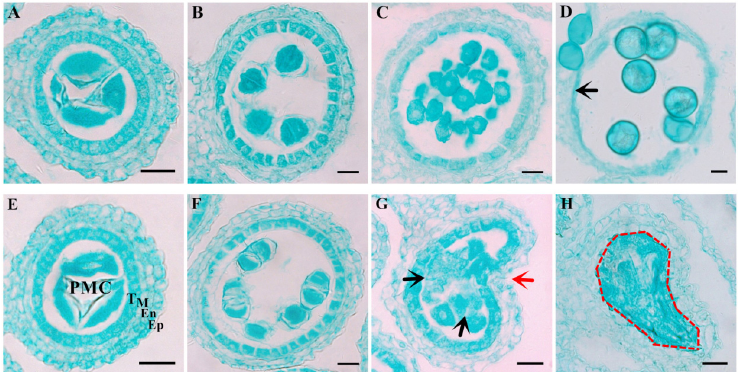
Figure 2. Cytological comparison of anther development in ms305 and fertile sibling at di ff erent stages. ( A – D ) Anther transverse sections of di ff erent developmental stages in fertile sibling; ( E – H ) Anther transverse sections of di ff erent developmental stages in ms305 . Notes: PMC, pollen mother cell; T, tapetum; M, middle layer; En, endothecium; Ep, epidermis. Red arrow, collapsed anther wall; Black arrow, degraded microspore. Dotted box, degraded microspore and tapetum cell. Scale bars = 50 µ